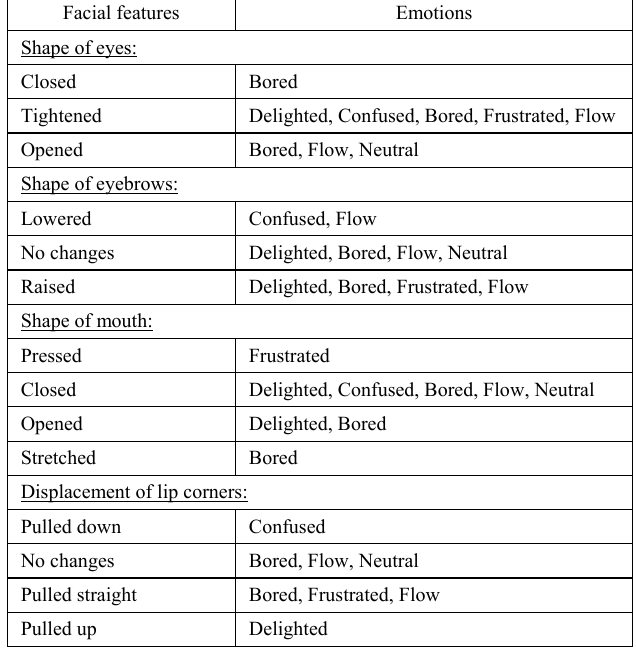
F ACIAL F EATURE E XPRESSIONS AND A PPROPRIATE E MOTIONS